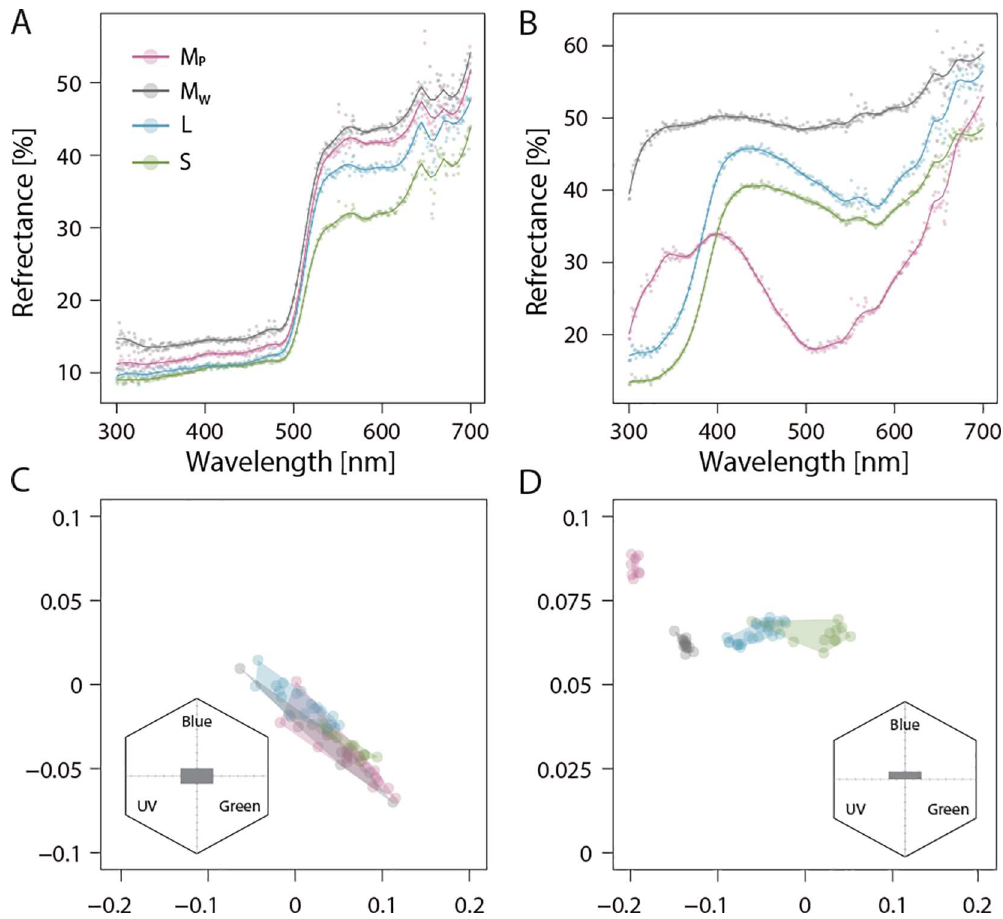
Fig 4. Mean spectral reflectancespectrum of the nectar guide (a) and tepal (b) of the three species, and the corresponding color loci plotted (c: nectar guide, d: tepal) in a hexagon color space. Areas indicatedby gray box in the inset plot were enlargedfor detail (d,